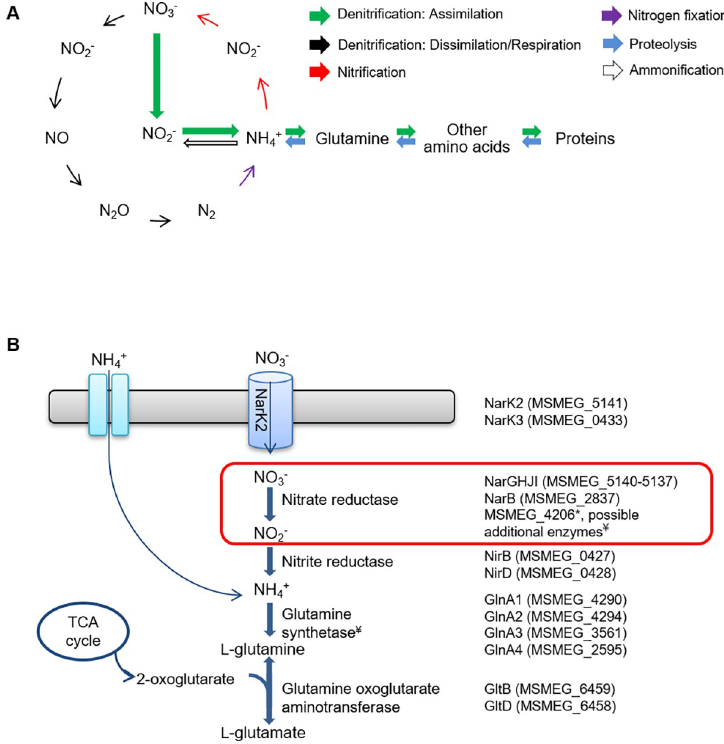
Fig 1. Nitrate reductase forms part of the Nitrogen cycle. (A) A schematic representation of an example of the Nitrogen cycle in prokaryotes is shown. Different prokaryotic organisms are able to catalyze each of the reactions depicted. Figure adapted from [5]. (B) Nitrate assimilation pathway in M . smegmatis . Genes encoding proteins for each step of the pathway are shown. � MSMEG_4206 is annotated as a pseudogene due to a frameshift. ¥ Five additional homologues of unknown function are present in the genome. Gene annotations were obtained from Mycobrowser and reference [6].